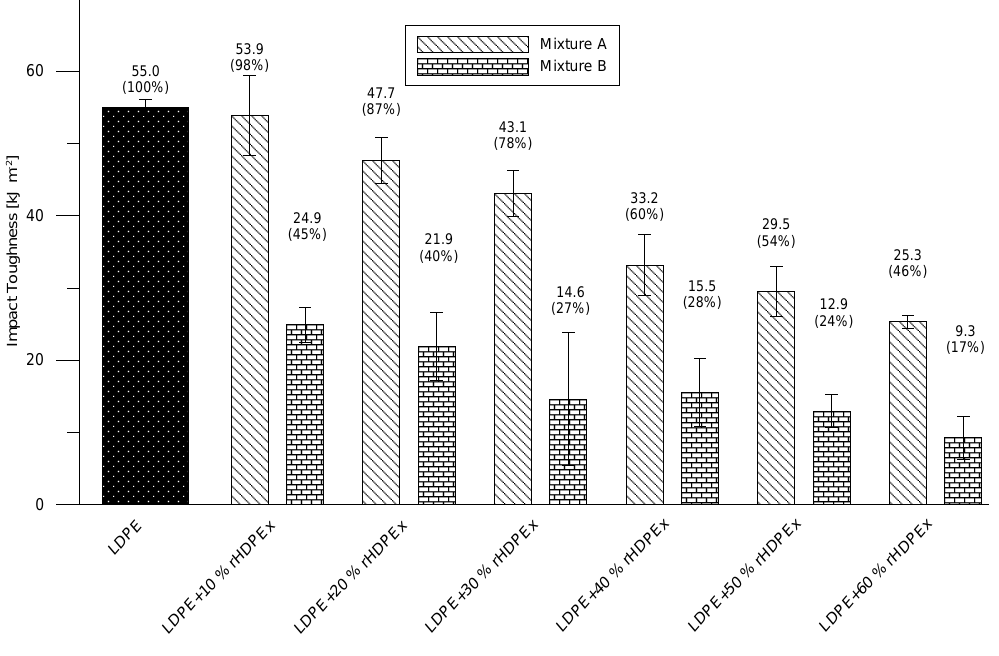
Figure 12. Impact toughness—Mixtures A and